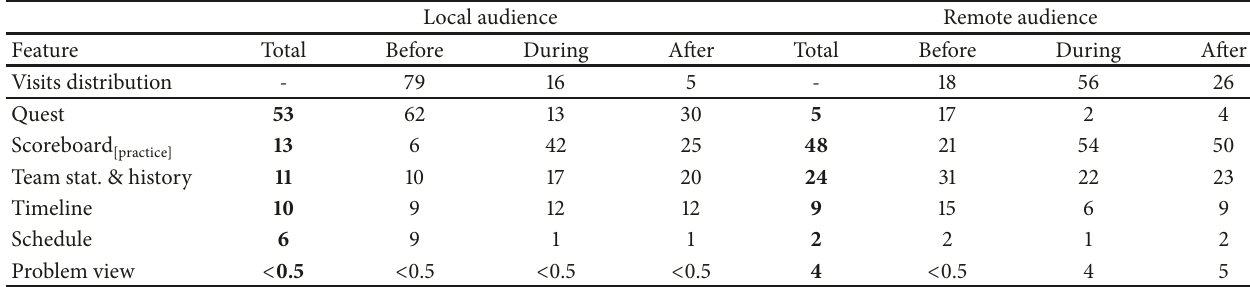
Table 6: Page view statistics [%].